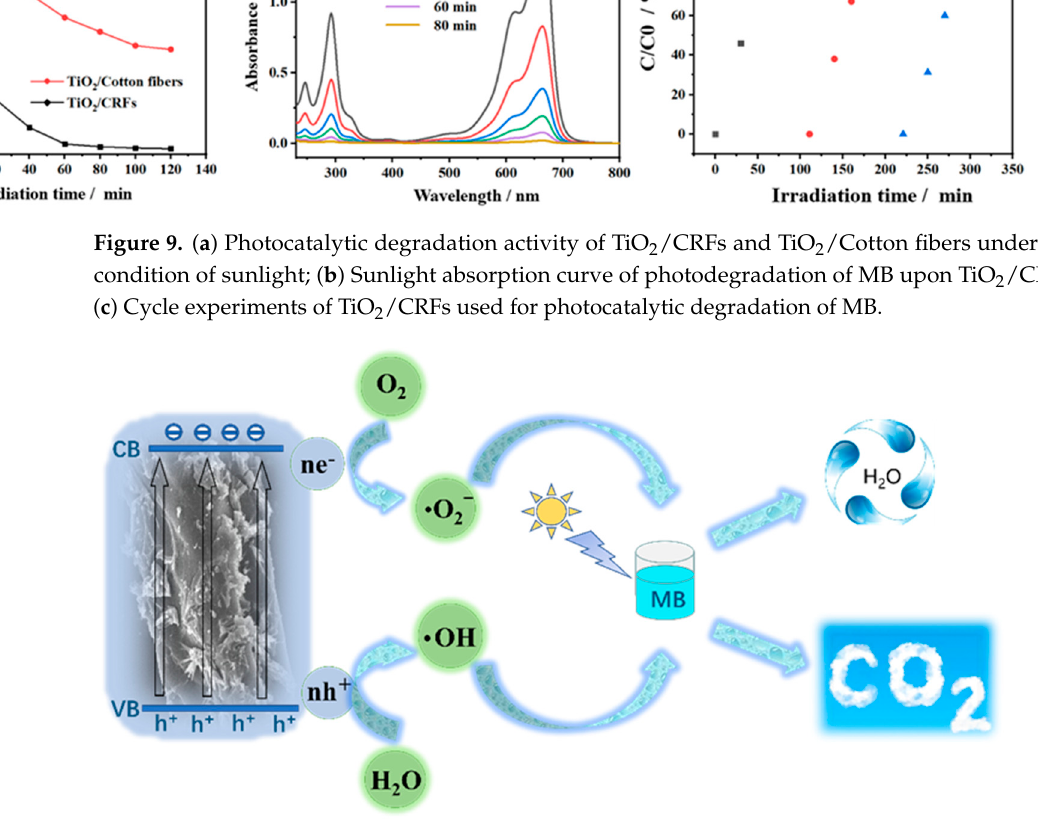
Figure 11. Image of ( a ) before and ( b ) after the photocatalytic degradation of methylene blue solu ‐ tion. Table 2. Research progress in degradation of MB dye by TiO 2 composite catalyst. Material